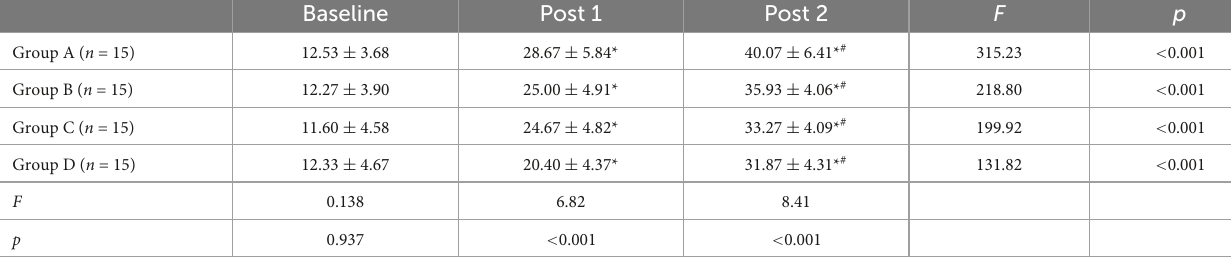
TABLE 3 Wolf Motor Function Test (WMFT) score for all the groups at different time points ( x ± S). Baseline